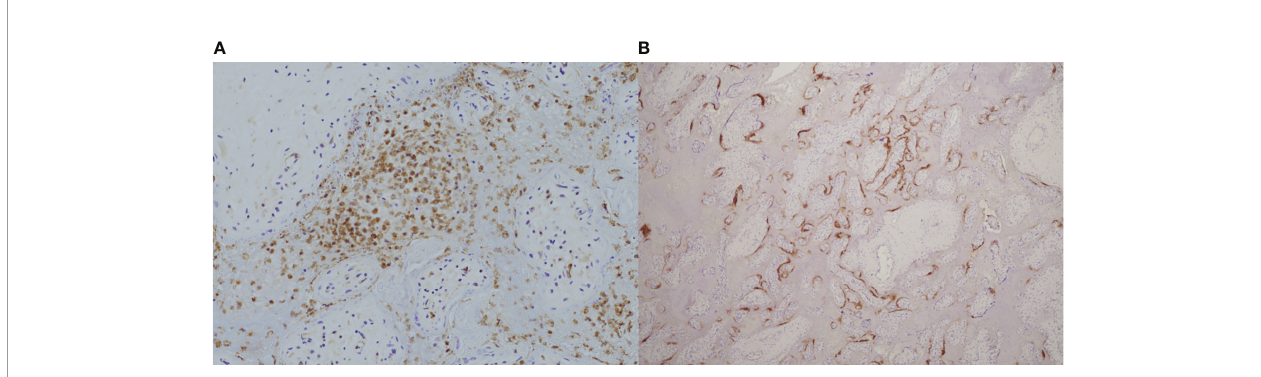
FIGURE 2 | Coexistence of chronic histiocytic intervillositis (CHI) with SARS-CoV-2 infection in a placenta from a late miscarriage at 20 weeks ’ gestation. (A) Immunohistochemical staining demonstrates CD68+ histiocytes (brown) in the intervillous space. (B) Positive expression of SARS-CoV-2 nucleocapsid protein (brown) by immunohistochemistry within the syncytiotrophoblast membrane of the same placenta. (A) , x20. (B)